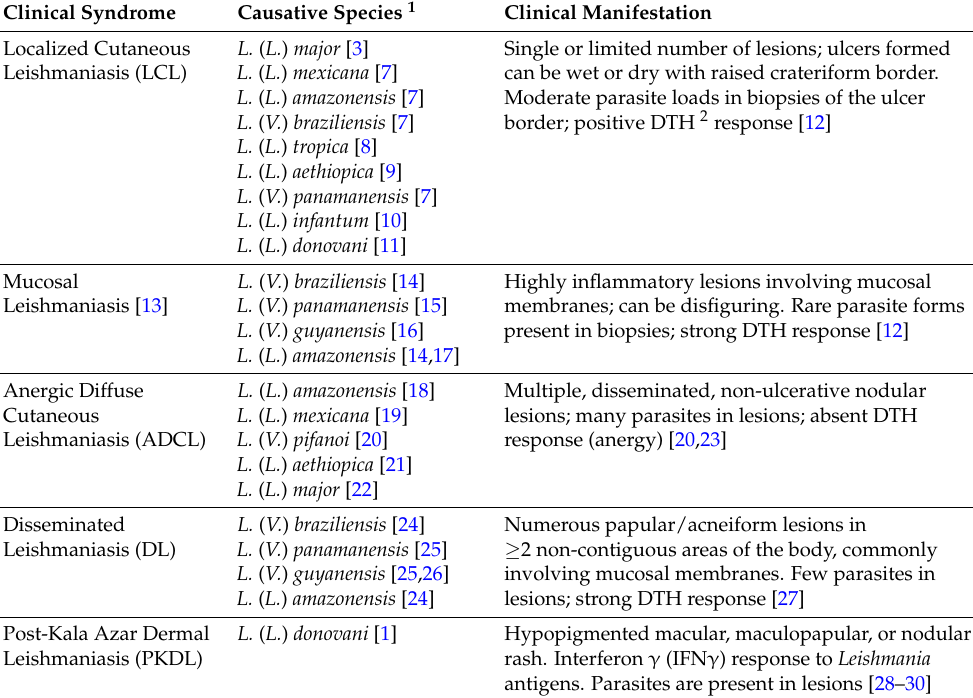
Table 1. Major clinical forms of tegumentary leishmaniasis and causative Leishmania